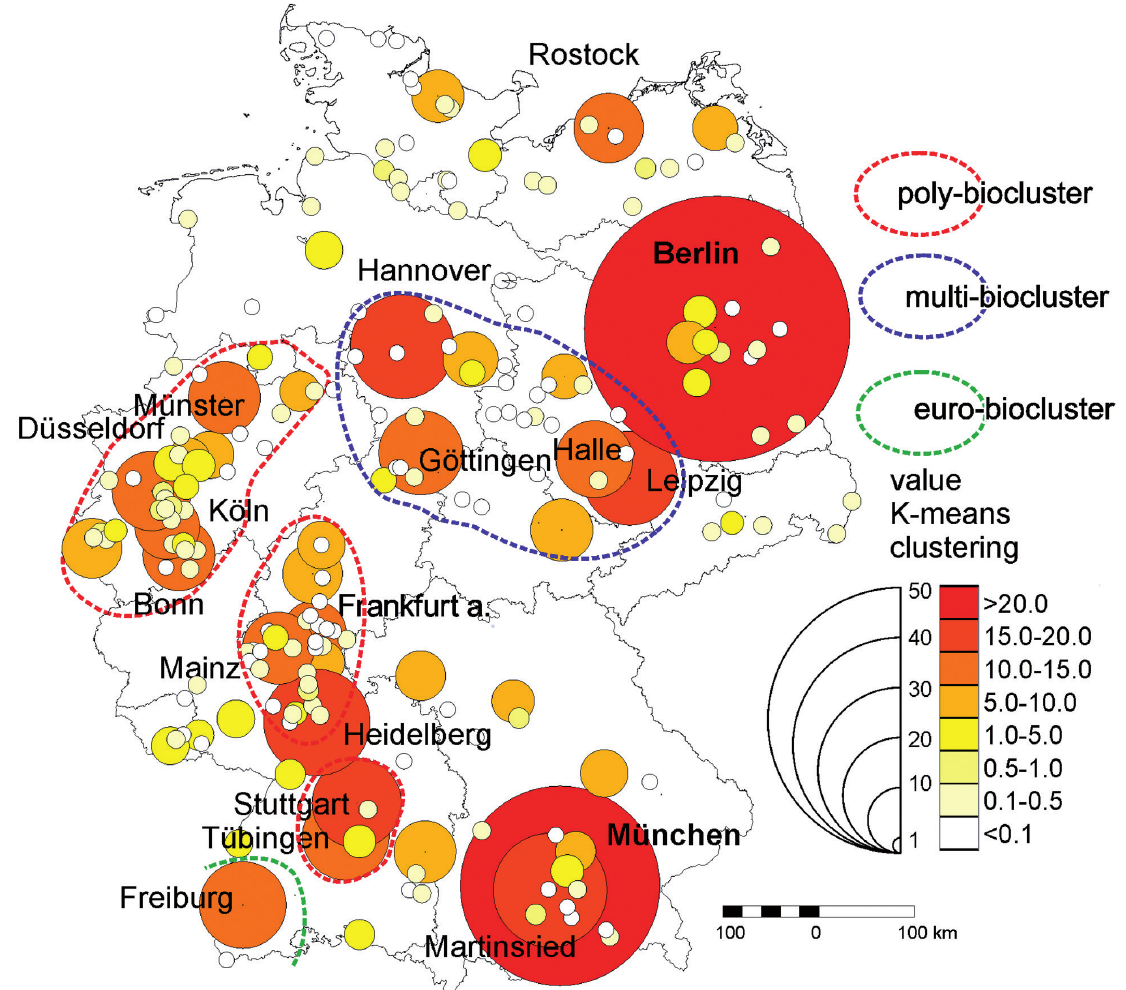
Fig. 13. Biotechnology centres in Germany, 2013 Source: own calculations based on the Internet portal